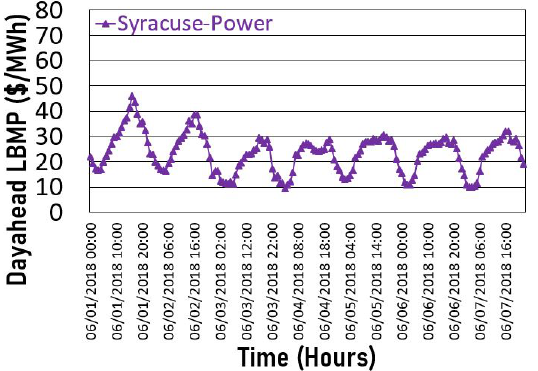
Figure 2. Locational Based Marginal Price of the generator, Syracuse Power on 1–7 June